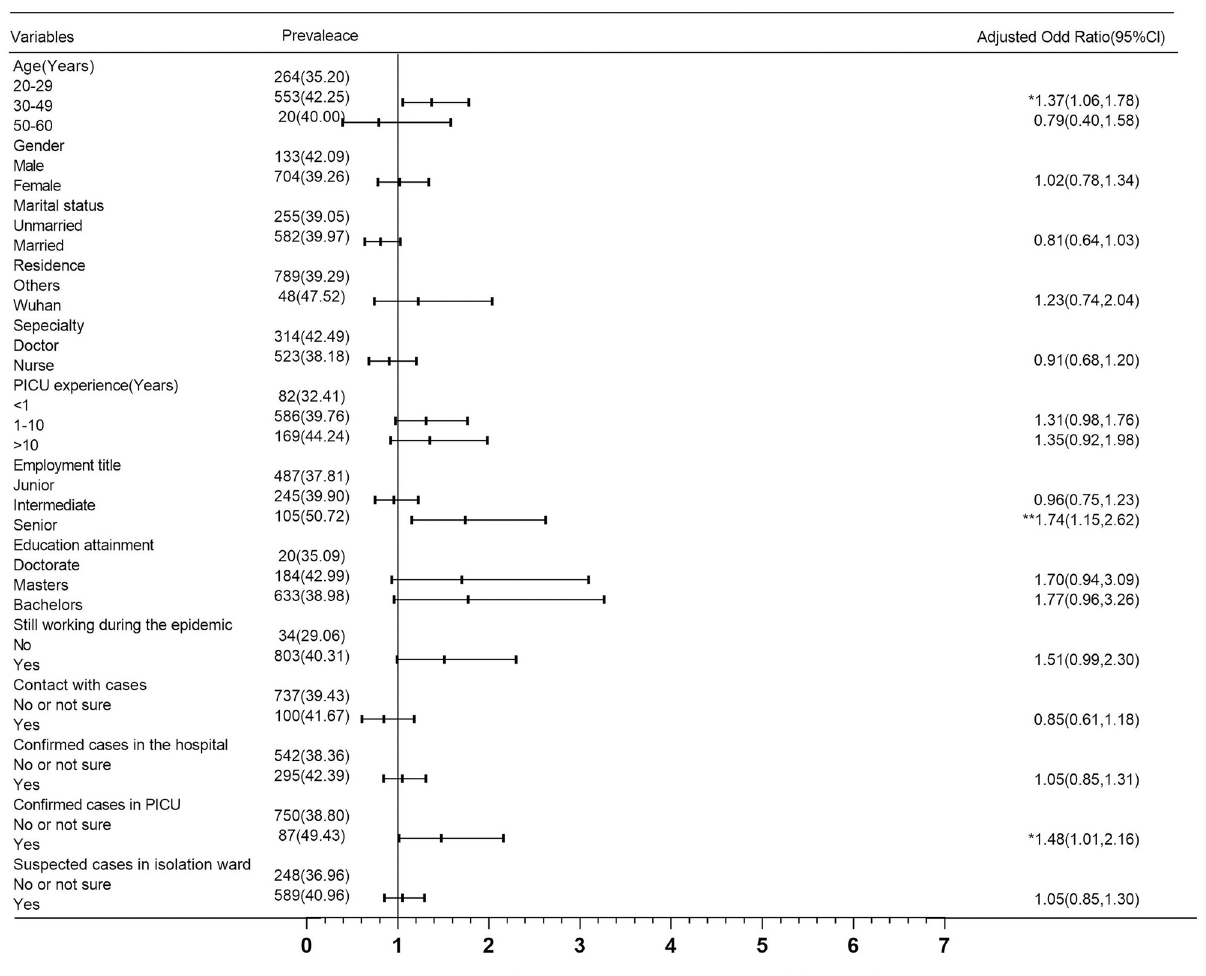
Fig 3. Multivariable logistic regression models for depression (DASS-21 depression subscale � 5) (n =